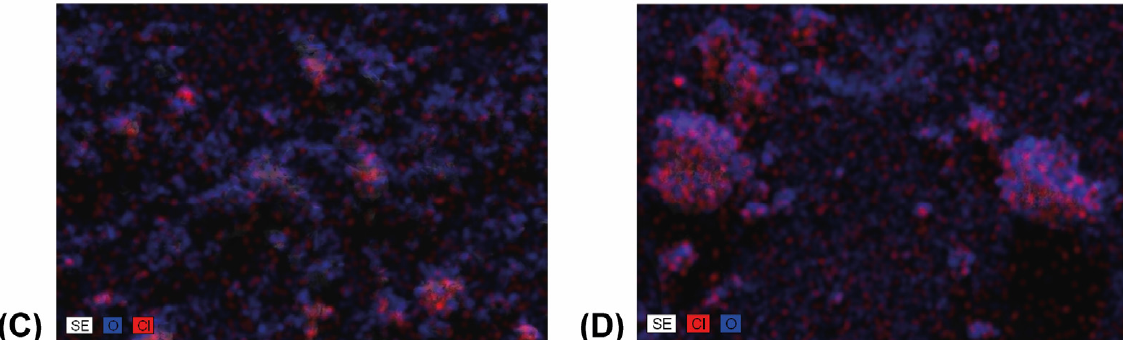
Figure 12. SEM images of samples taken prior to grinding ( A ) and after 20 min of grinding ( B ) showed less only DIMEB containing separated particles after grinding. The corresponding EDS mapping images ( C , D ) showed more evenly distributed FEN in the aggregates, with a higher ratio on the surface, after 20 min of grinding.